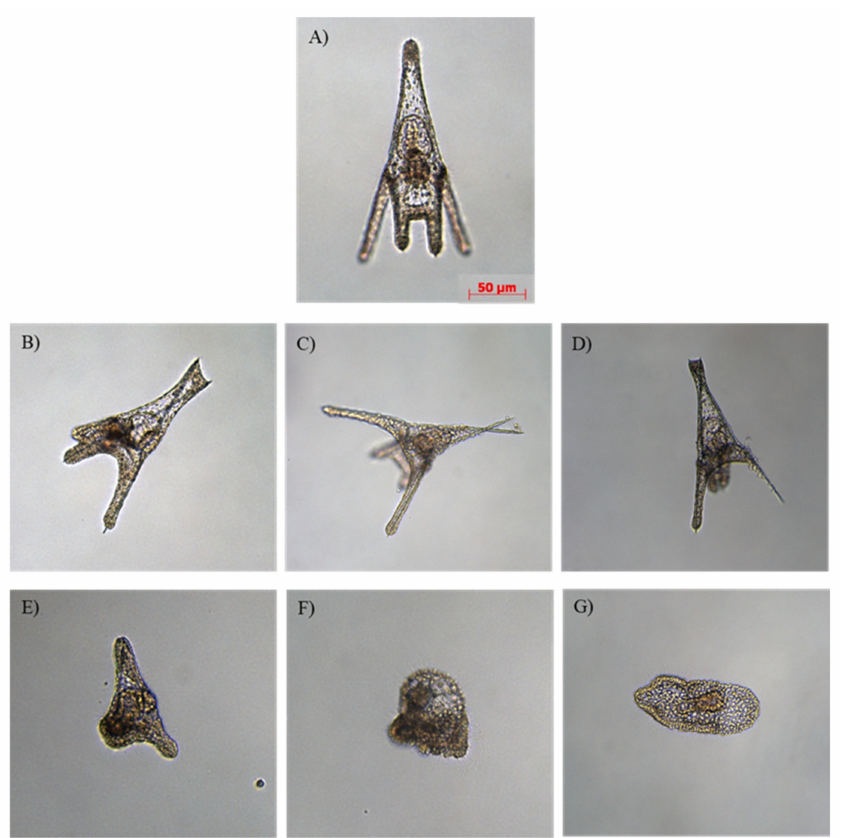
Figure 1. Examples of malformations observed in ( B – E ) p. lividus plutei deriving from adults exposed to PAHs and PCBs and in ( F , G ) embryos still at the gastrula stage deriving from adults exposed to PCBs in comparison with ( A ) control embryos deriving from adults reared in a tank with sediment without contaminants. ( B ) poorly-formed apex; ( C ) crossed at the apex with wider aperture of the arms; ( D ) degraded arms; ( E ) delayed and abnormal body; ( F , G ) malformed